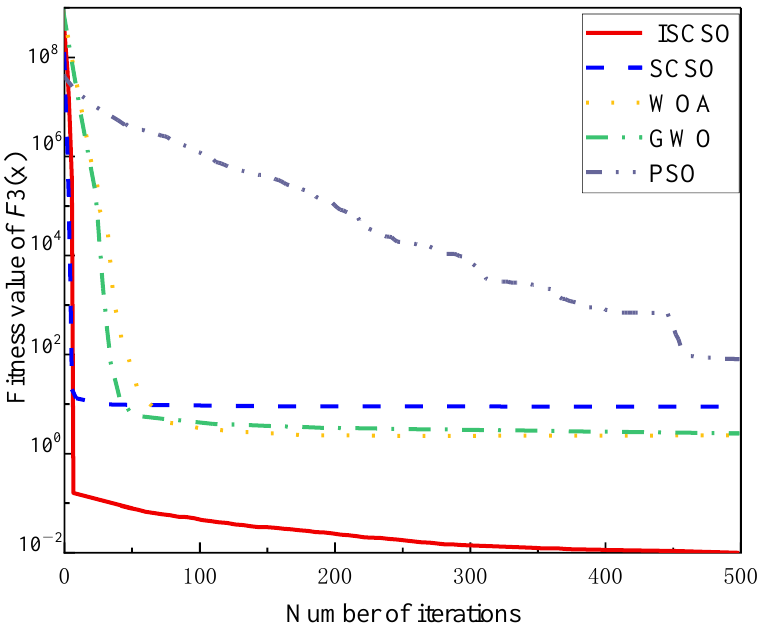
Figure 12. Comparison of the optimization search for F 3 ( x ) for each optimization algorithm.